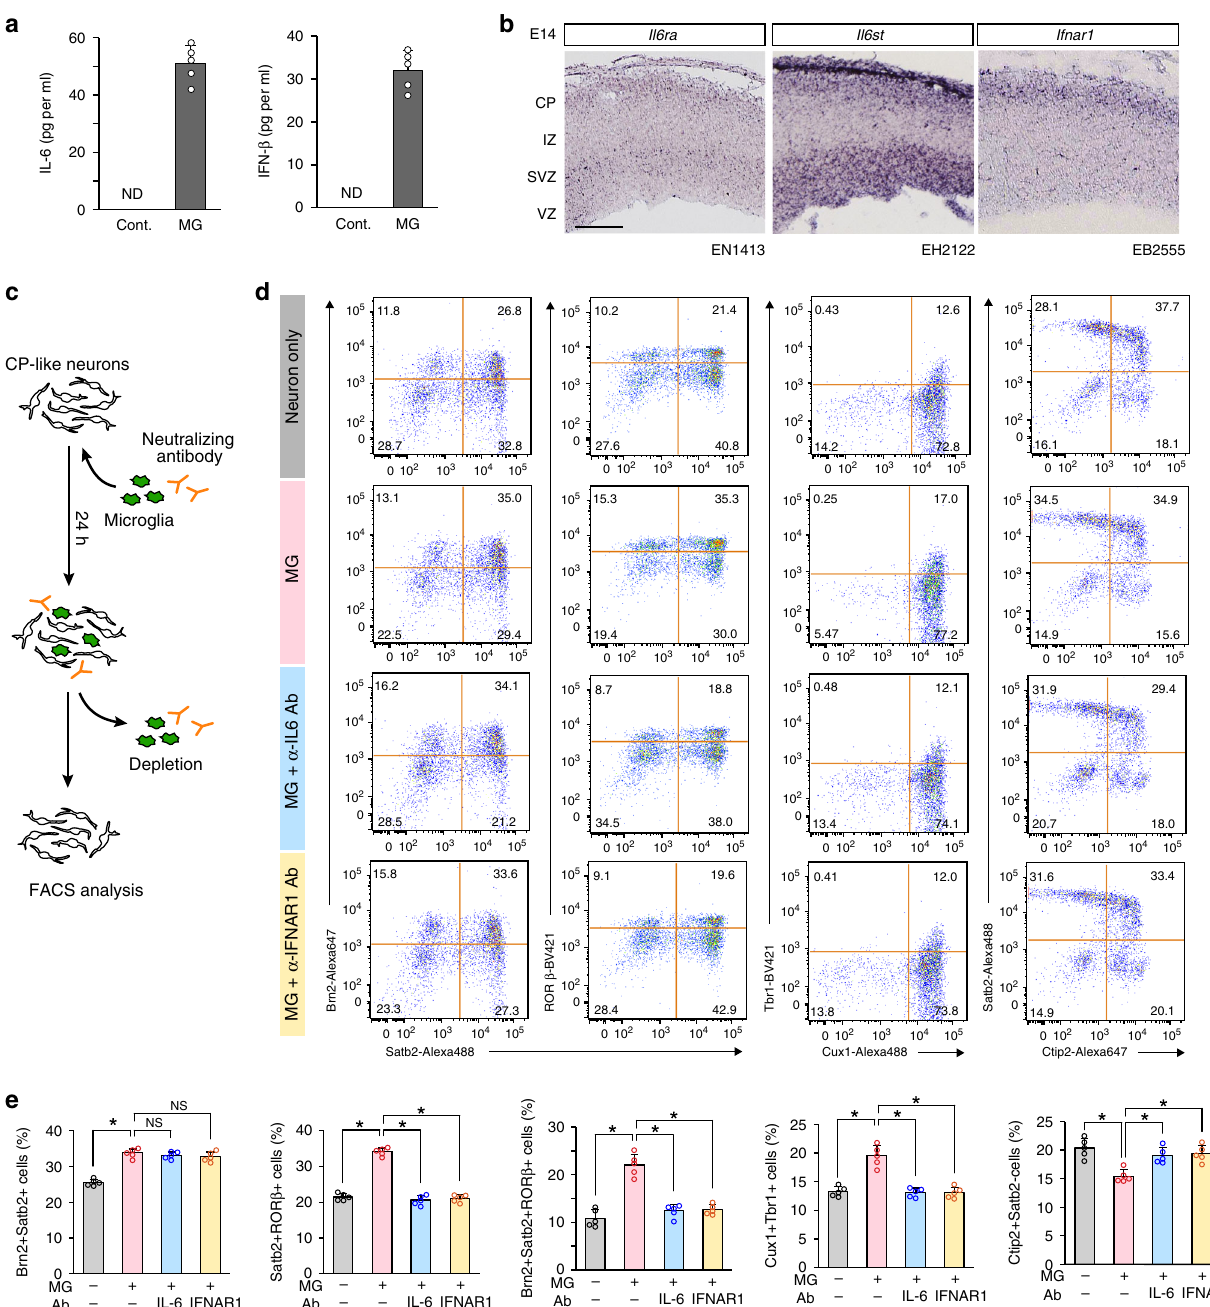
Fig. 9 Differentiative marker expression in CP-like neurons is sensitive to IL-6 and IFN-I secreted by microglia. a The quanti fi cation of IL-6 and IFN- β released into the culture media of in vitro-prepared CP-like neurons with or without microglia ( n = 5 independent cultures; ND not detected). b GenePaint mouse atlas of Il6ra , Il6st (gp130) , and Ifnar1 mRNA expression in E14.5 mice (https://gp3.mpg.de). GenePaint set IDs are indicated at the bottom right of the panels. Scale bar, 100 µ m. c An experimental schematic for the IL-6 and IFN-I neutralization assay. In advance, microglia isolated by CD11b magnetic separation were pretreated with anti-IL-6 or anti-IFNAR1 antibodies for 30 min. After coculturing with microglia in the presence of neutralizing antibodies for 24 h, in vitro-prepared CP-like neurons were puri fi ed by selecting cells negative for CD11b. d Representative FACS analysis data of CP-like neurons after coculture with or without microglia. e Graphs depicting the average percentage of Brn2 + Satb2 + , Satb2 + ROR β + , Brn2 + Satb2 + ROR β + , Cux1 + Tbr1 + , and Ctip2 + Satb2 − cells (two-sided Steel – Dwass test; n = 5 independent cultures; P = 0.045, 0.836, and 0.721 for Brn2 + Satb2 + cells, P = 0.045, 0.045, and 0.045 for Satb2 + ROR β + cells, P = 0.045, 0.045, and 0.045 for Brn2 + Satb2 + ROR β + cells, P = 0.045, 0.045, and 0.045 for Cux1 + Tbr1 + cells, and P = 0.045, 0.045, and 0.045 for Ctip2 + Satb2 − cells [in the order of control vs microglia-added samples without antibodies, microglia-added samples without antibodies vs those treated with anti-IL-6 antibodies, and microglia-added samples without antibodies vs those treated with anti-IFNAR1 antibodies]). Data are presented as the mean values ± S.D. Source data are provided as a Source Data